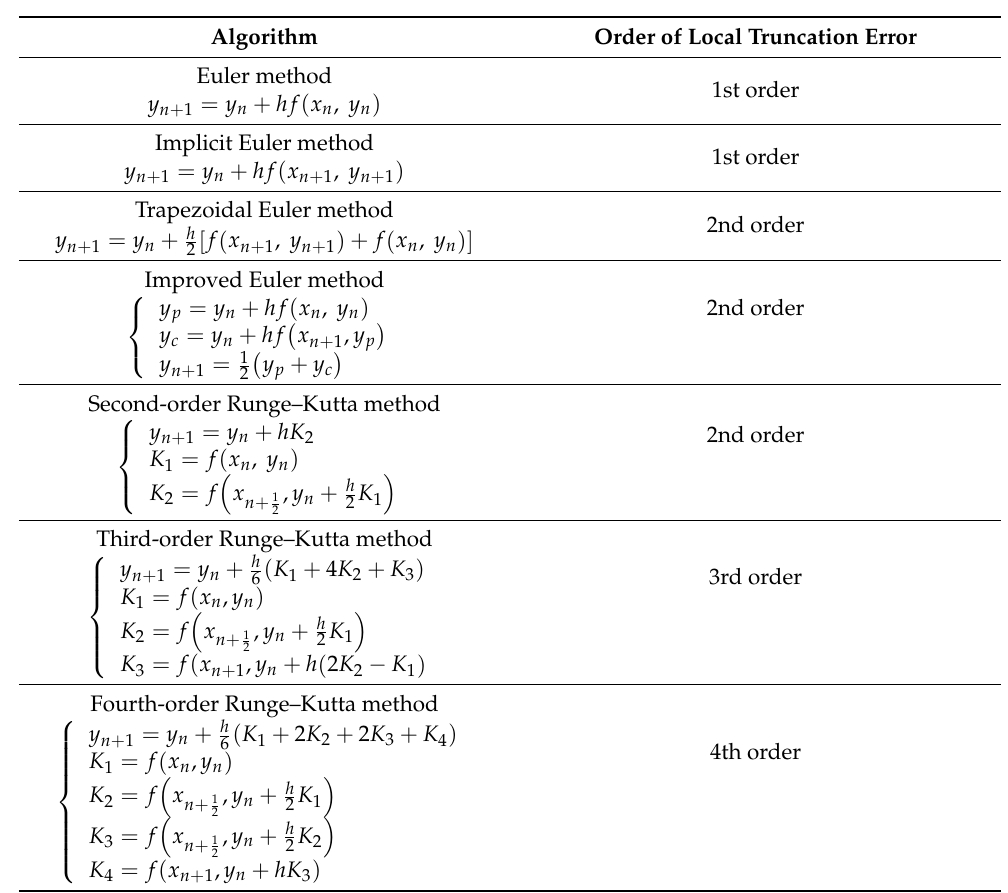
Table 1. Orders of local truncation errors for different numerical